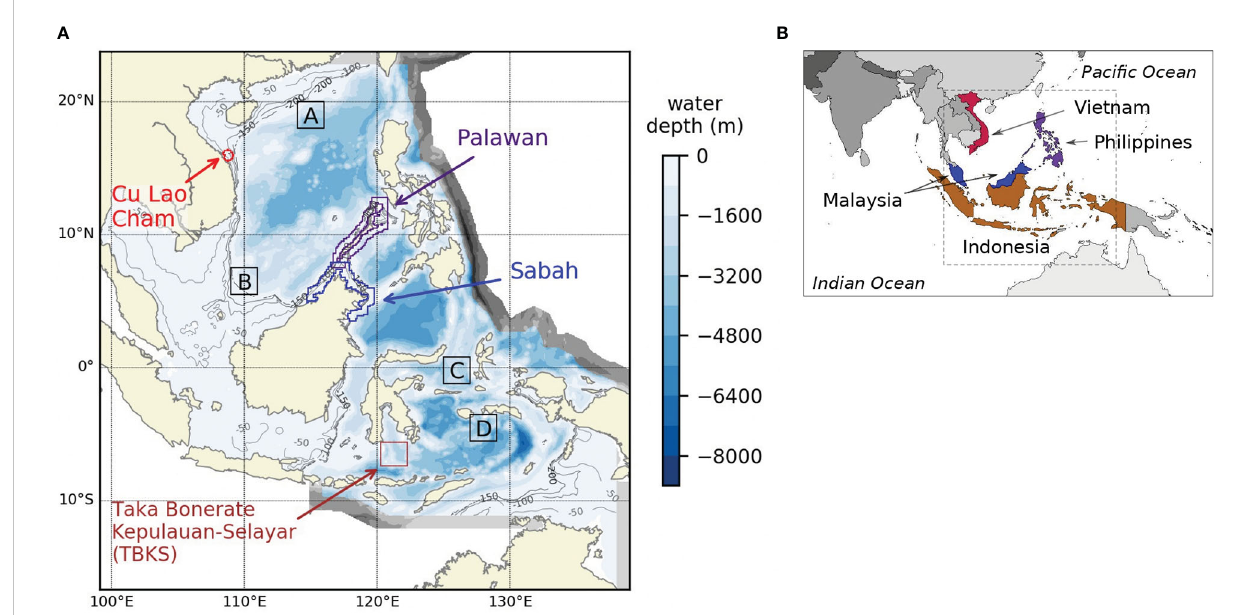
FIGURE 1 (A) shows the model domain and sample areas referred to in the text. Blue and grey areas are the model domain, with the colors showing water depth; the grey parts are near the open boundary and omitted from analysis in the rest of this paper. White shows sea areas outside the model domain. The four areas outlined and labelled in color show regions around the four coastal study sites. Boxes A, B, C and D are sample areas for four different offshore parts of the domain; their locations are given in section 2.2. (B) shows the modelled area embedded in the wider geographical context. The countries where the four coastal study sites are located are shown in